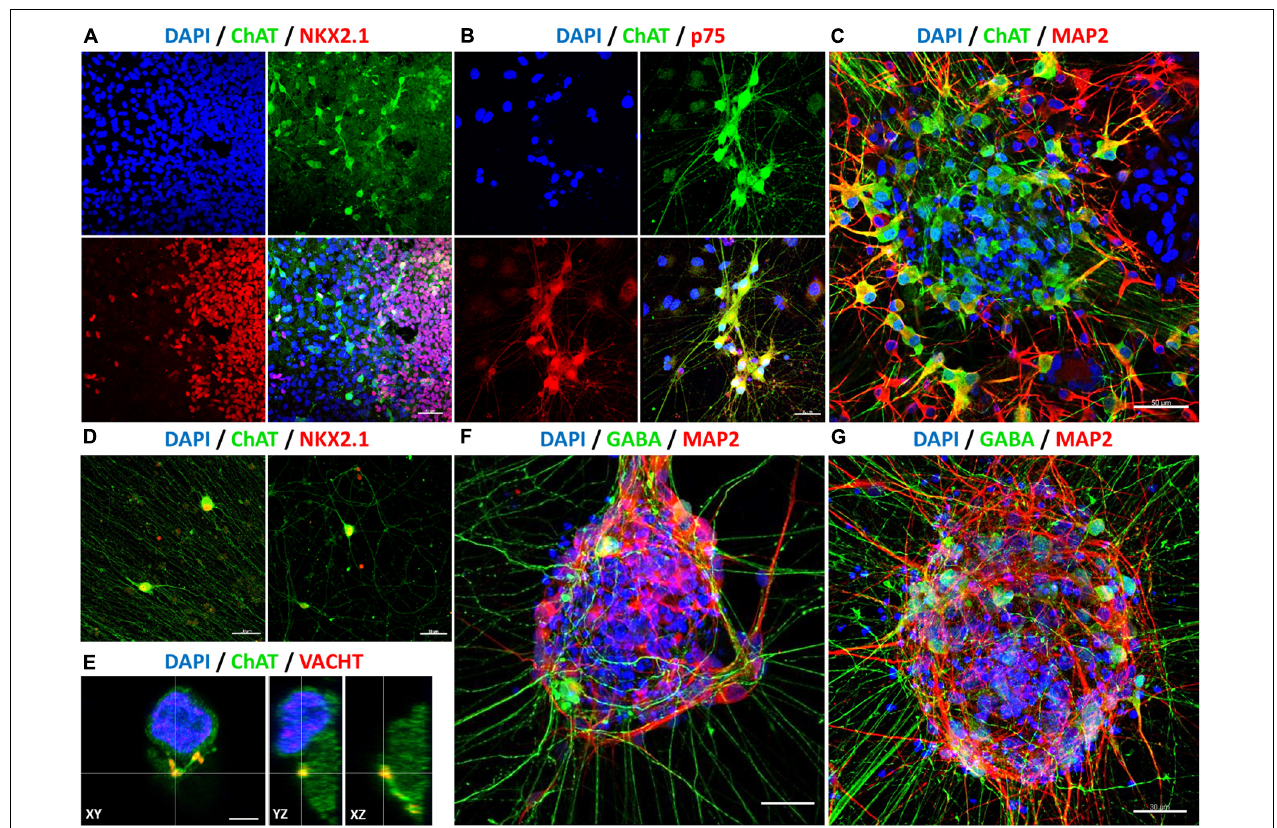
FIGURE 7 | Determination of neuronal identity with immunofluorescence stainings after 60 days in vitro (40 days after final maturation). After rostro-ventralization, the presence of BFCNs was confirmed by coexpression of ChAT (green: A–E ), with NKX2.1 (red: A,D ), p75 (red: B ), MAP2 (red: C ), and VACHT (red: E ). Compared to unpatterned samples (F) , qualitatively more GABA-positive neurons and neurites (GABA: green, MAP2: red) were observed in patterned cell populations (G) . Nuclei were stained with DAPI (blue). Scale bars: 40 µ m (A) , 30 µ m (B,D,F,G) , 50 µ m (C) , and 5 µ m (E)